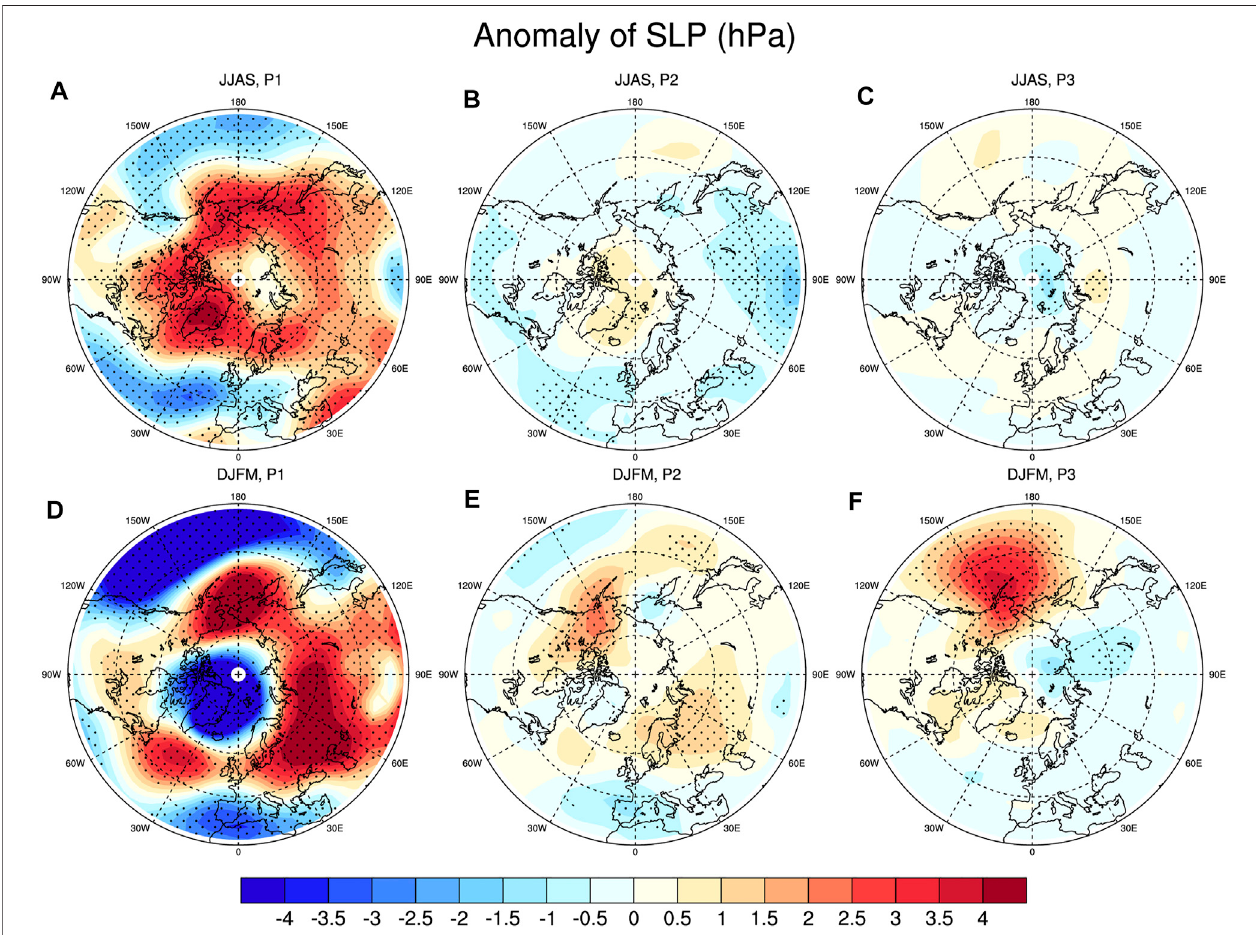
FIGURE 9 | Ensemble-mean simulated sea level pressure (SLP) anomalies in summer (JJAS, top panels) and winter (DJFM, bottom panels) during Period-1 (A,D) , Period-2 (B,E) , and Period-3 (C,F) . The dots denote areas with con fi dence exceeding the 90% level.